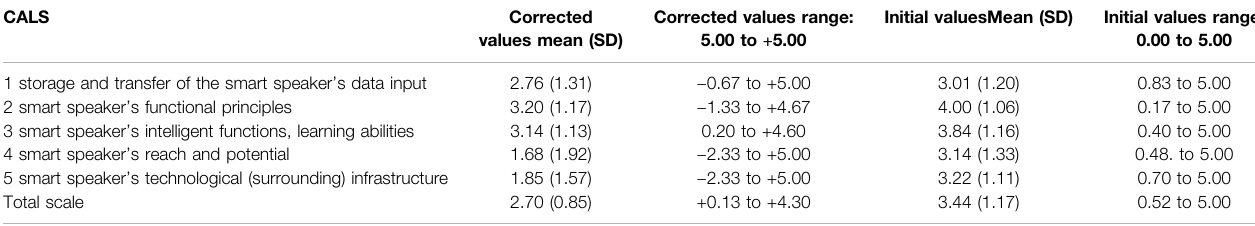
TABLE 5 | CAL-scores of the student sample. CALS Corrected